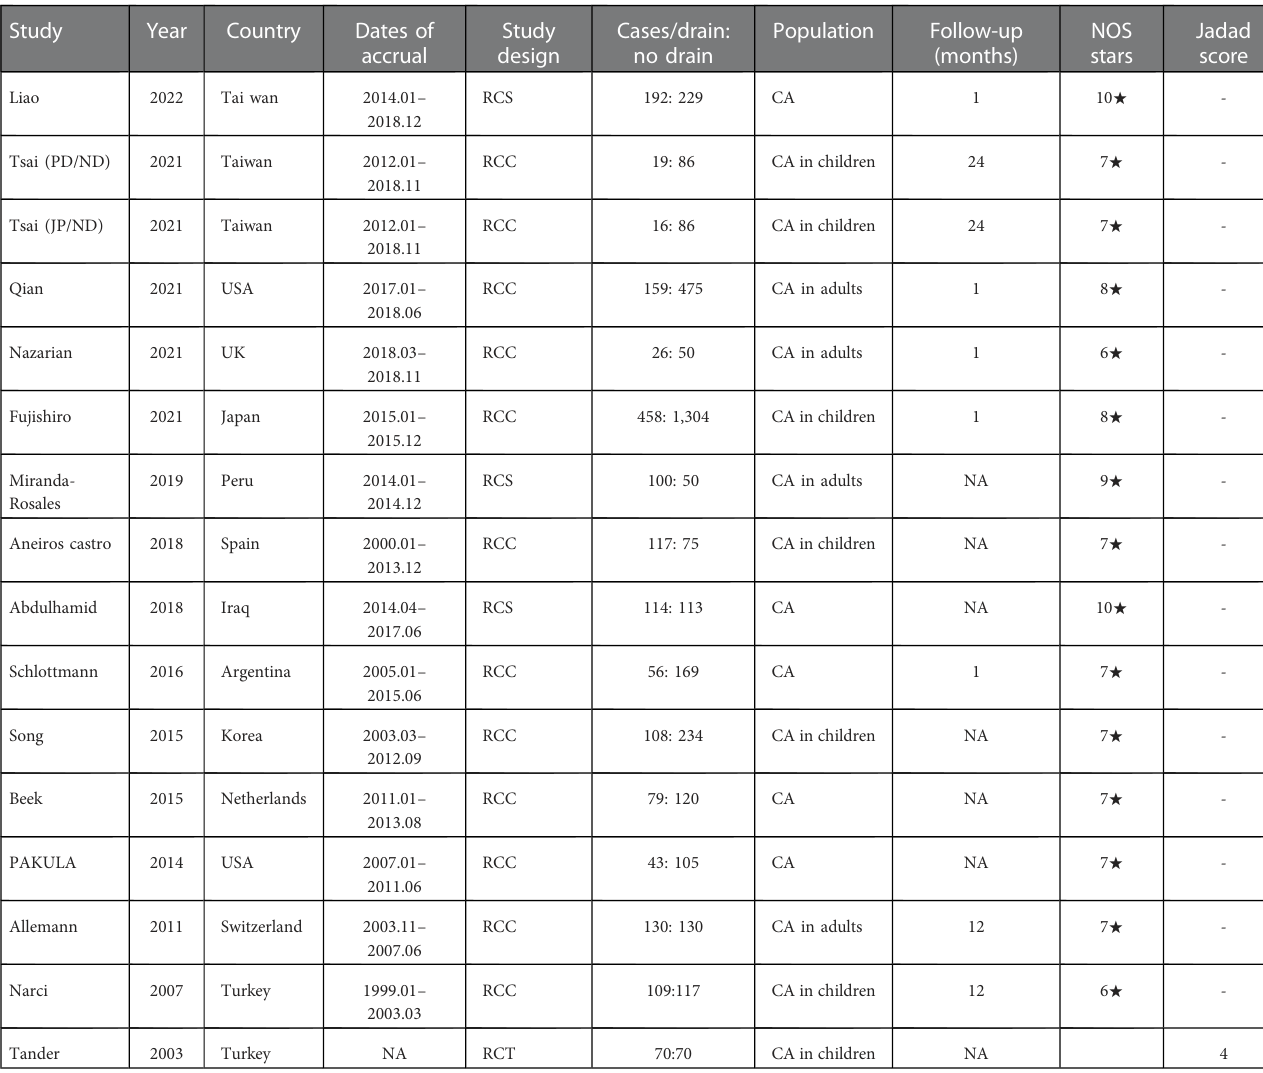
TABLE 1 The basic characteristics and quality evaluation results of included